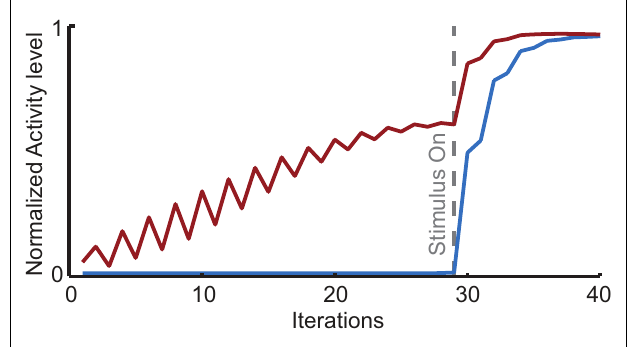
FIGURE 8 | Simulations of the effect of cued attention performed with the HNO model in the presence of spontaneous activity. The results predict that the neuronal response to a stimulus presentation is faster and accompanied by pre-stimulus inter-areal phase-locking when attention is cued before the stimulus appears. Red line: neuronal activity inV4 at the location of a stimulus when that location receives cued attention prior to stimulus presentation at t = 28. Blue line: same situation, but without cued attention. Attention now only influences neuronal activity after stimulus-driven activity has reachedV4.The gray dotted line indicates the moment when stimulus-driven activity